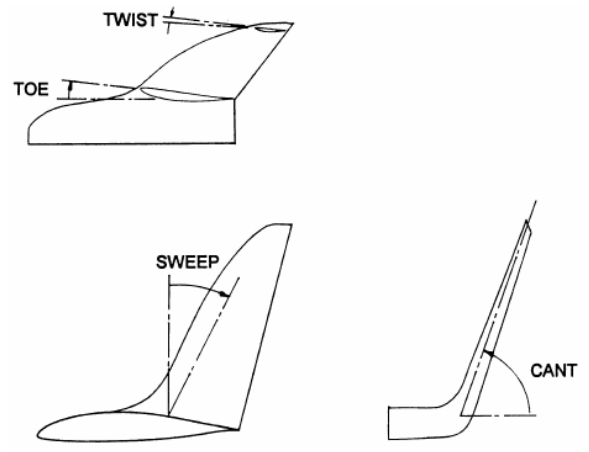
Figure 1. Basic winglet parameters terminology (from Maughmer